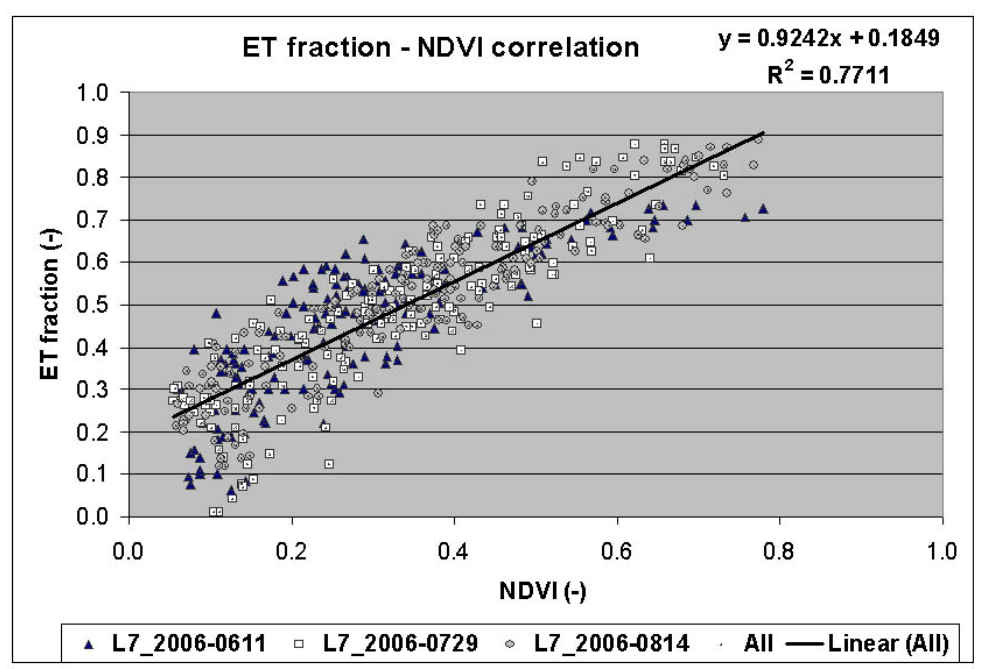
Figure 10. Landsat ETM+ ET fraction versus NDVI